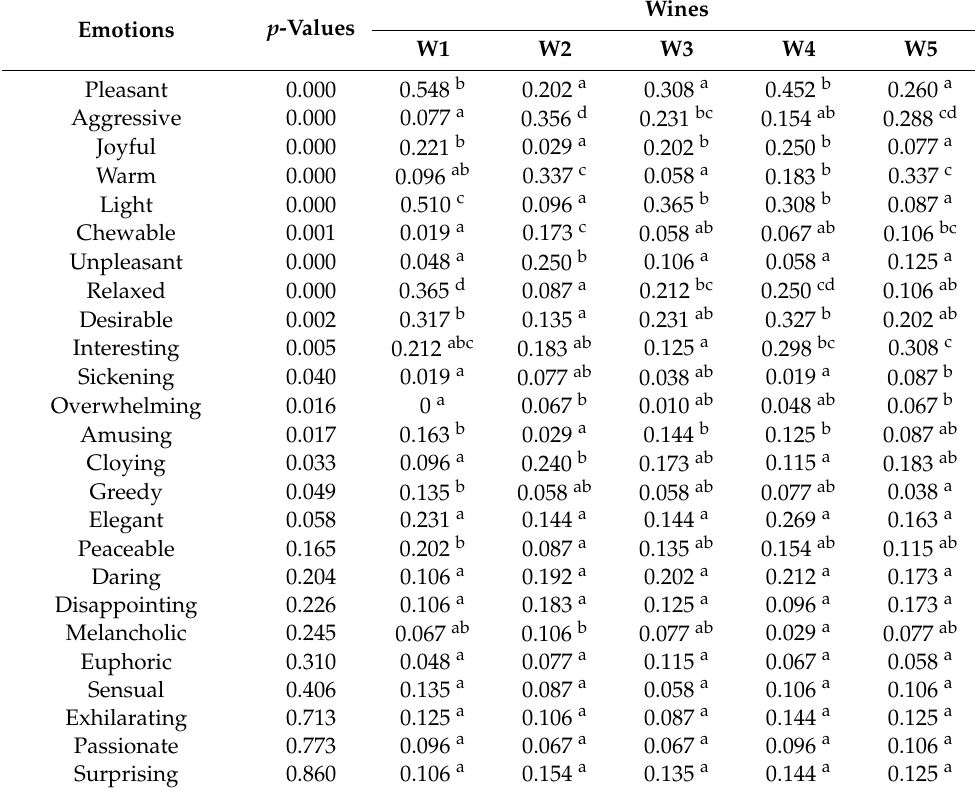
Table 5. Cochran’s Q test for each emotion of the CATA